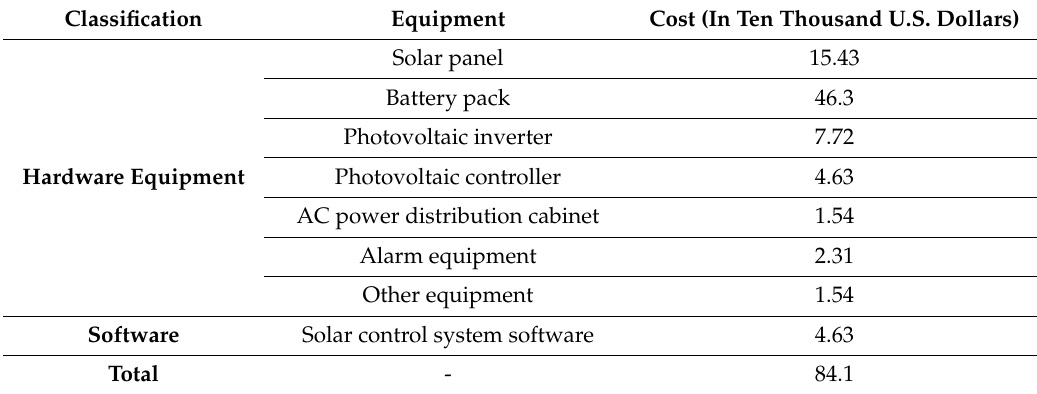
Table 2. Ship modification investment